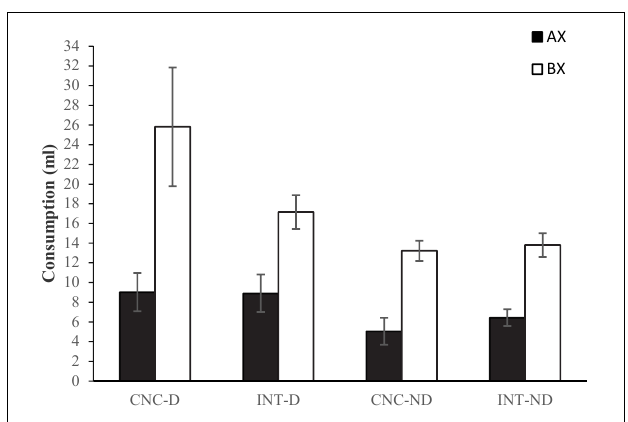
FIGURE 5 | Consumption (ml, mean ± SEM) of the AX and BX solutions during the test trials for the four groups of Experiment 3.